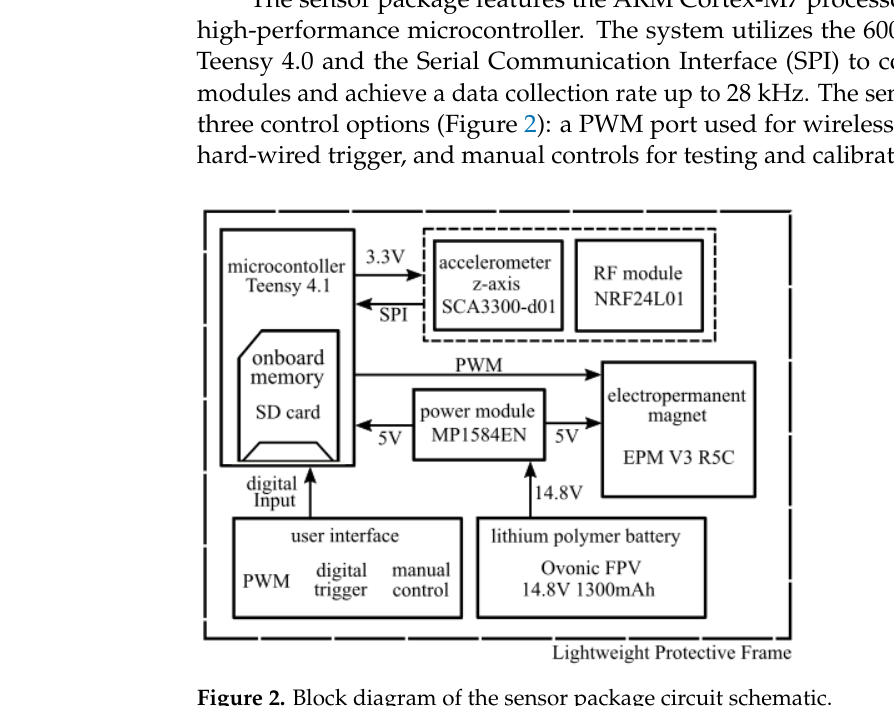
Figure 2. Block diagram of the sensor package circuit